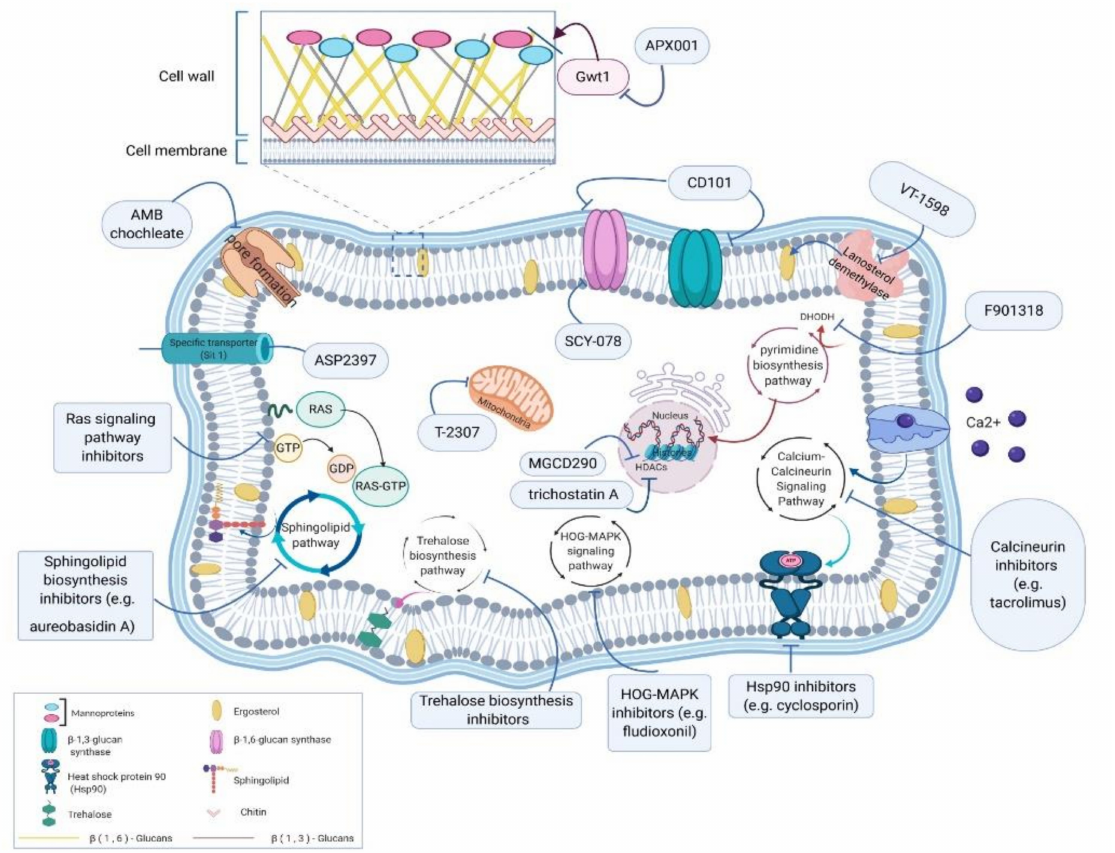
Figure 1. Target sites and potential pathways of the novel antifungals. This diagram of a fungal cell indicates various molecules that can be tackled by antifungal agents (blue boxes), including cell wall, cell membrane, and also intracellular targets such as mitochondria and processes like metabolisms and stress